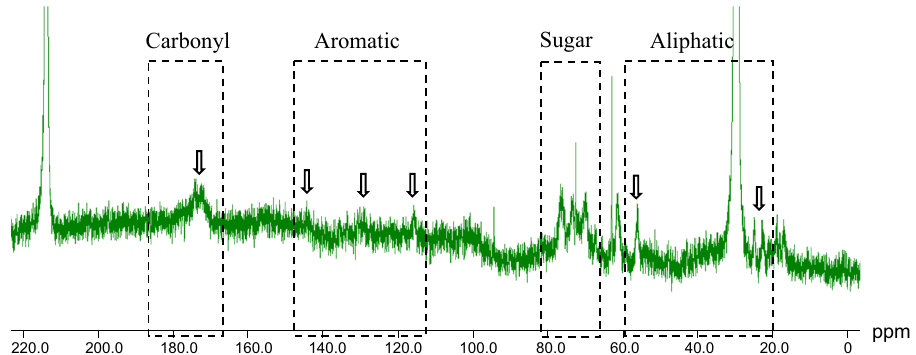
Figure 5. 13 C-NMR spectrum [100 MHz, D 2 O: acetone- d 6 (1:1)] of the > 3 kDa fraction of the corn silk water